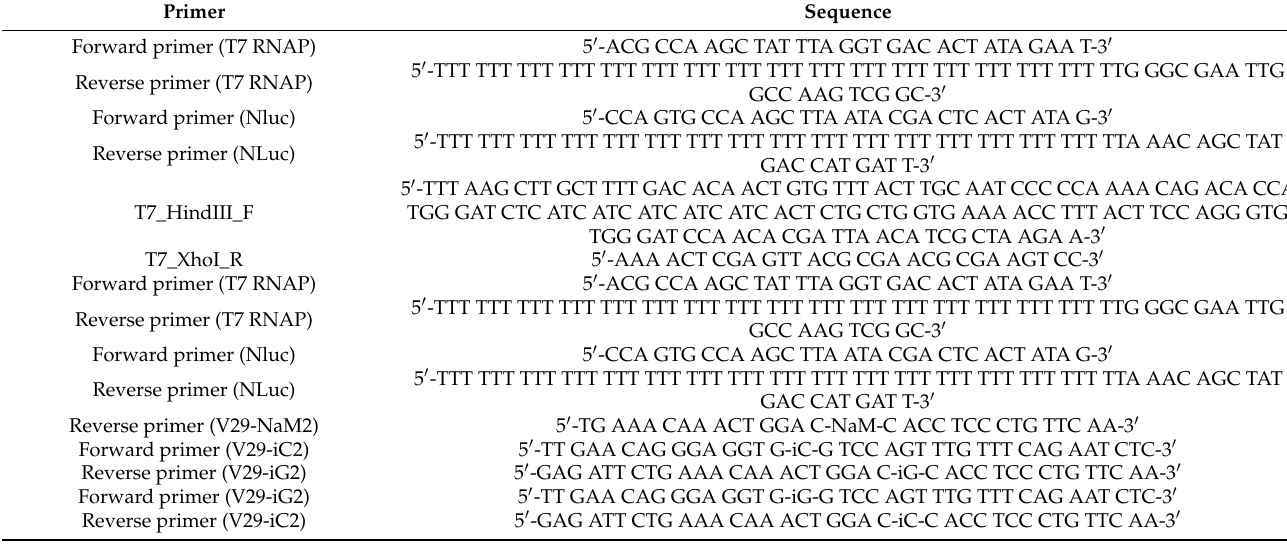
Table 3. Sequences of